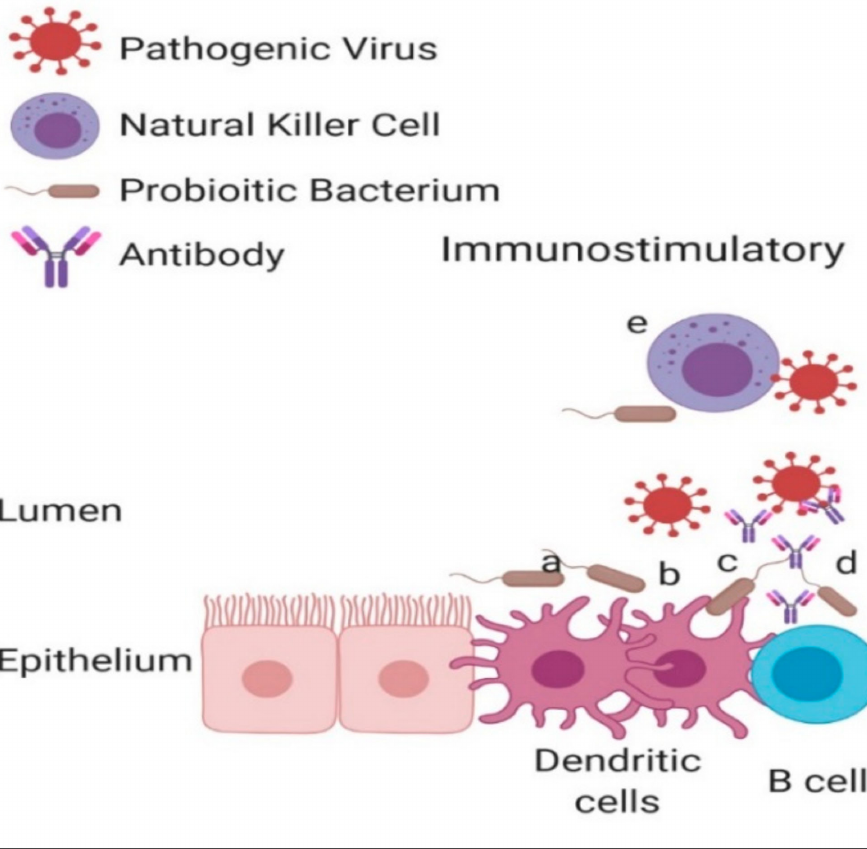
Figure 2. Immunomodulatory effects offered by probiotics to enhance the inhibition of viral shedding. To confer an immunomodulatory effect on its host, probiotics can either elicit immuno-stimulatory or -repressive effects. Mechanisms ( a , b ) represent direct DC activation by probiotic EPS and DNA identification, respectively. The technique represented by ( c ) also represents the enhanced DC activation upon identification of probiotic factors; however, this technique requires the DC engulfment of a probiotic. Once activated, the DCs produce pro-inflammatory cytokines which initiate further activation of innate and acquired immune response systems. Enhanced immunoglobulin production initiated by the recognition of probiotics by B cells is represented by the letters ( d , e ), showing the increased cytotoxicity attributed to NK cells upon their recognition of probiotic